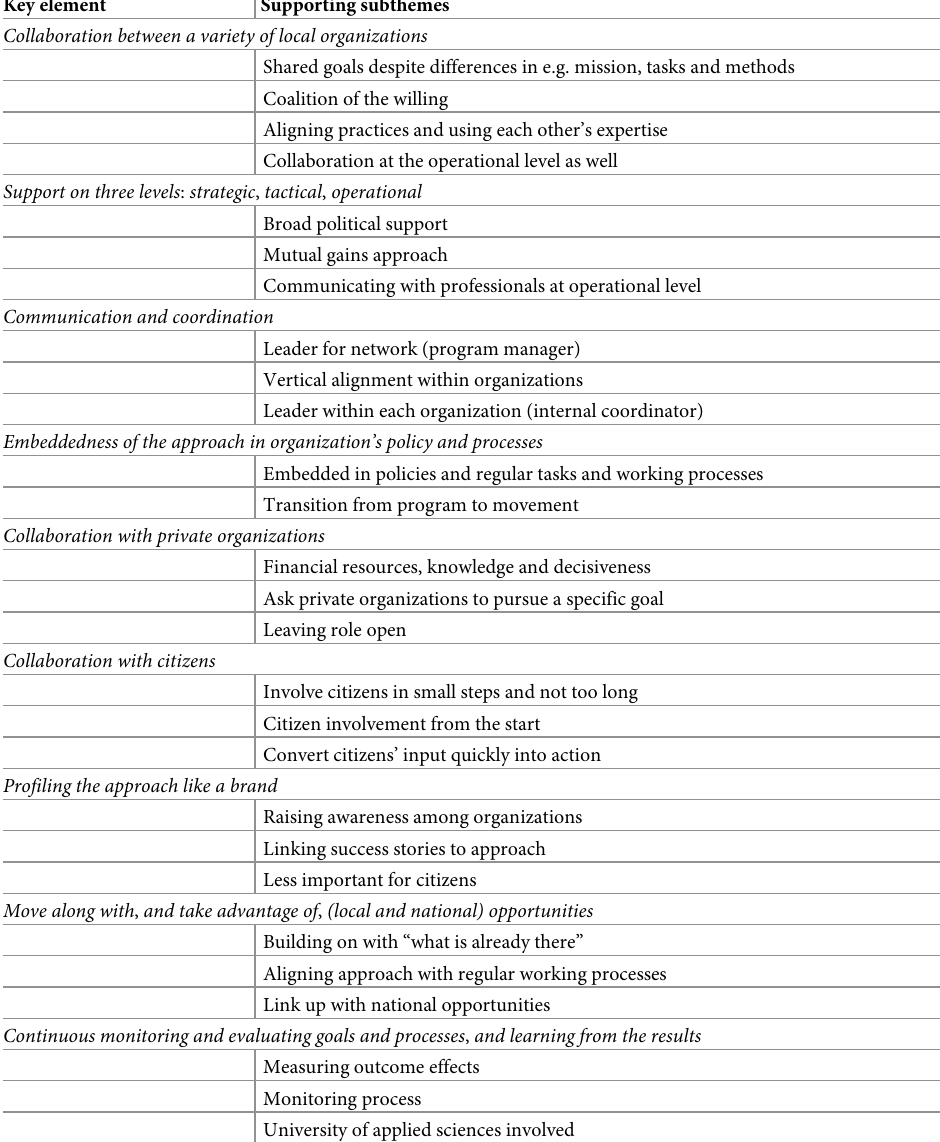
Table 2. Overview of key elements with supporting sub-themes. Key